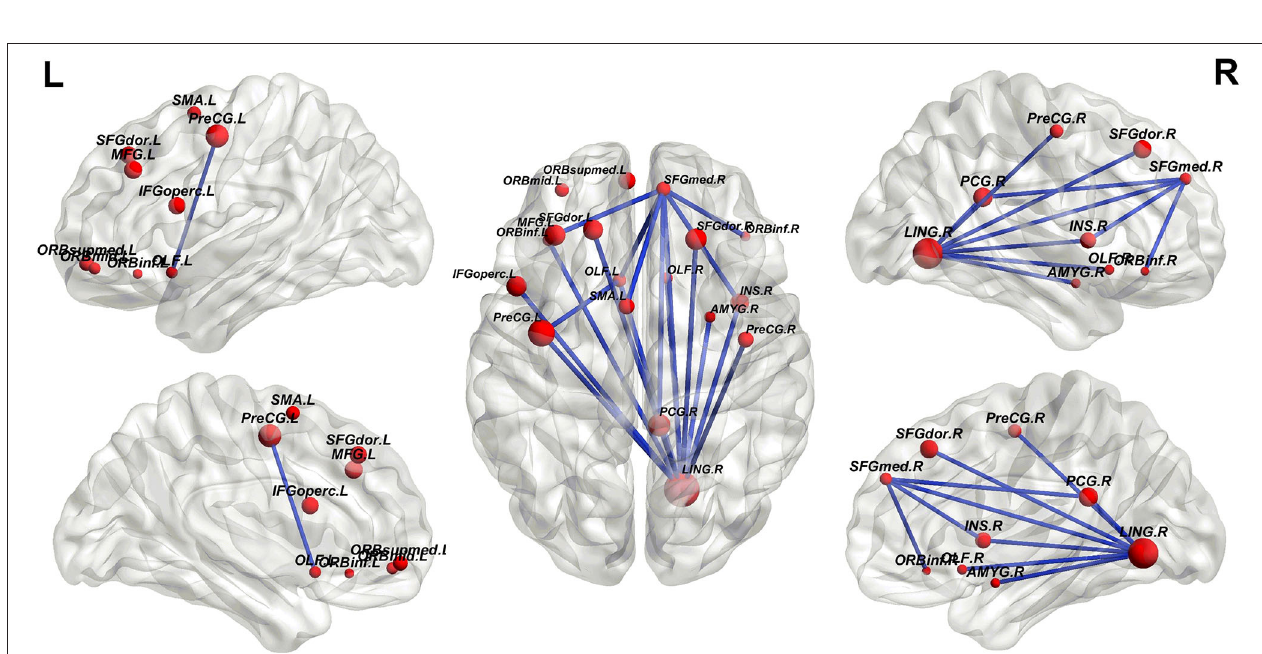
FIGURE 6 | Top 20 functional connections corresponding to the extracted optimal features.